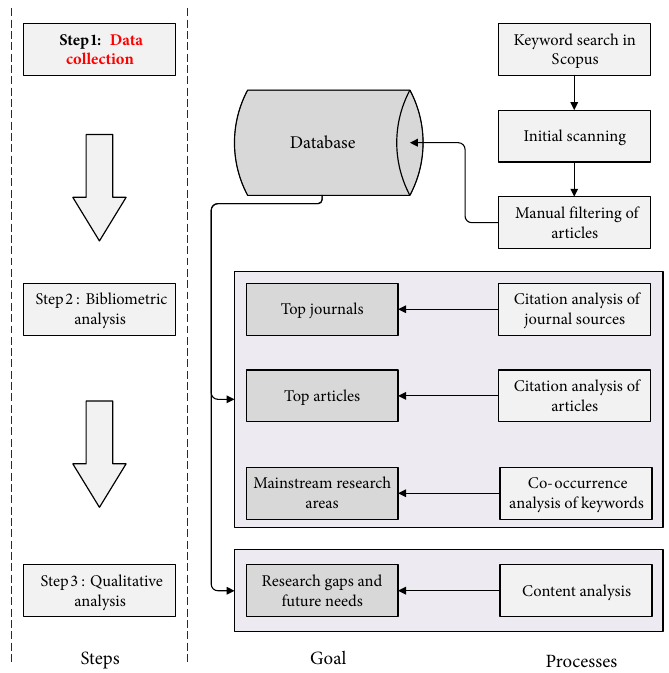
Figure 1. The three-step workflow of the literature